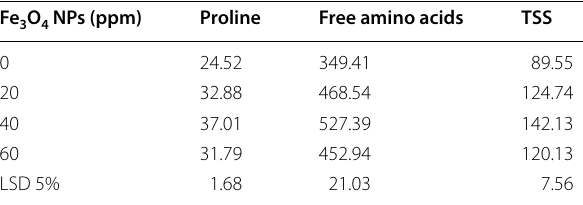
Table 4 Effect of foliar application with Fe osmoprotectants (proline, free amino acids and total soluble sugars) of Moringa oleifera L.